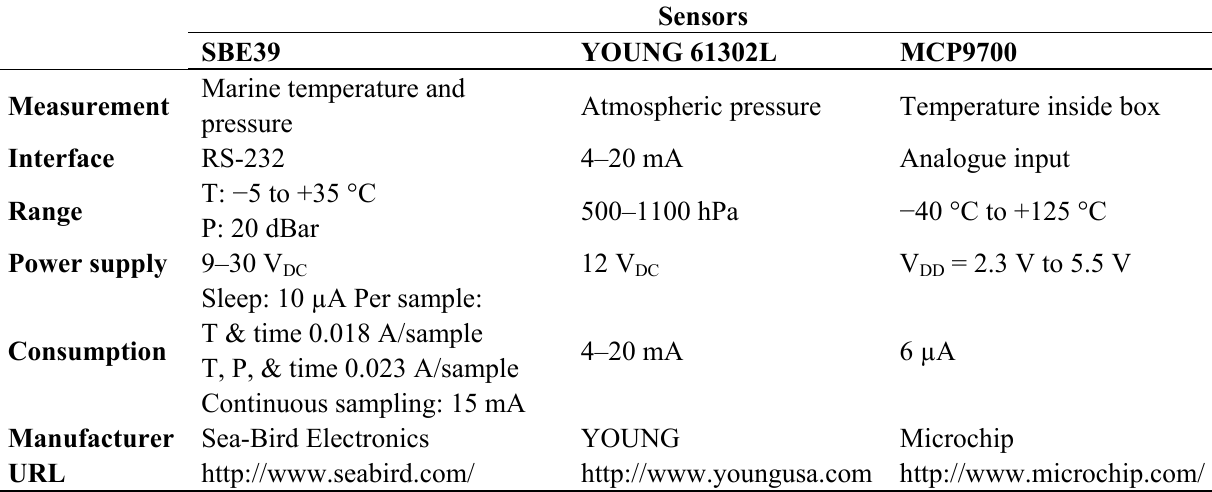
Table 1. Summary of devices used in the